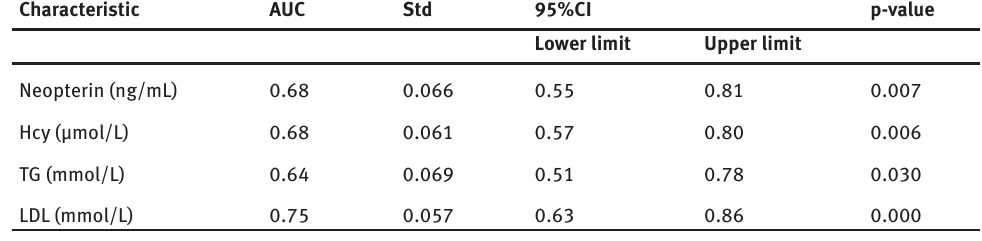
Table 3: The Prediction performance of serum neopterin, homocysteine TG and LDL for IS. Characteristic AUC Std 95%CI p-value Lower limit